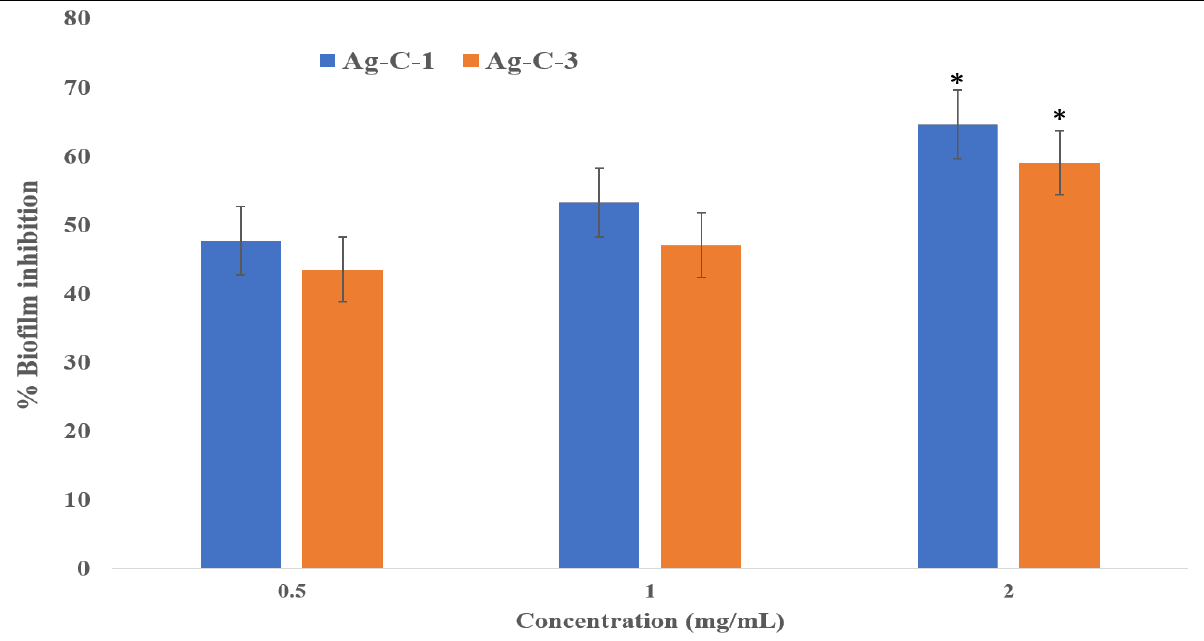
Figure 7. Effects of Ag-C-1 and Ag-C-3 on the biofilm-forming abilities of E. coli . * p < 0.05.